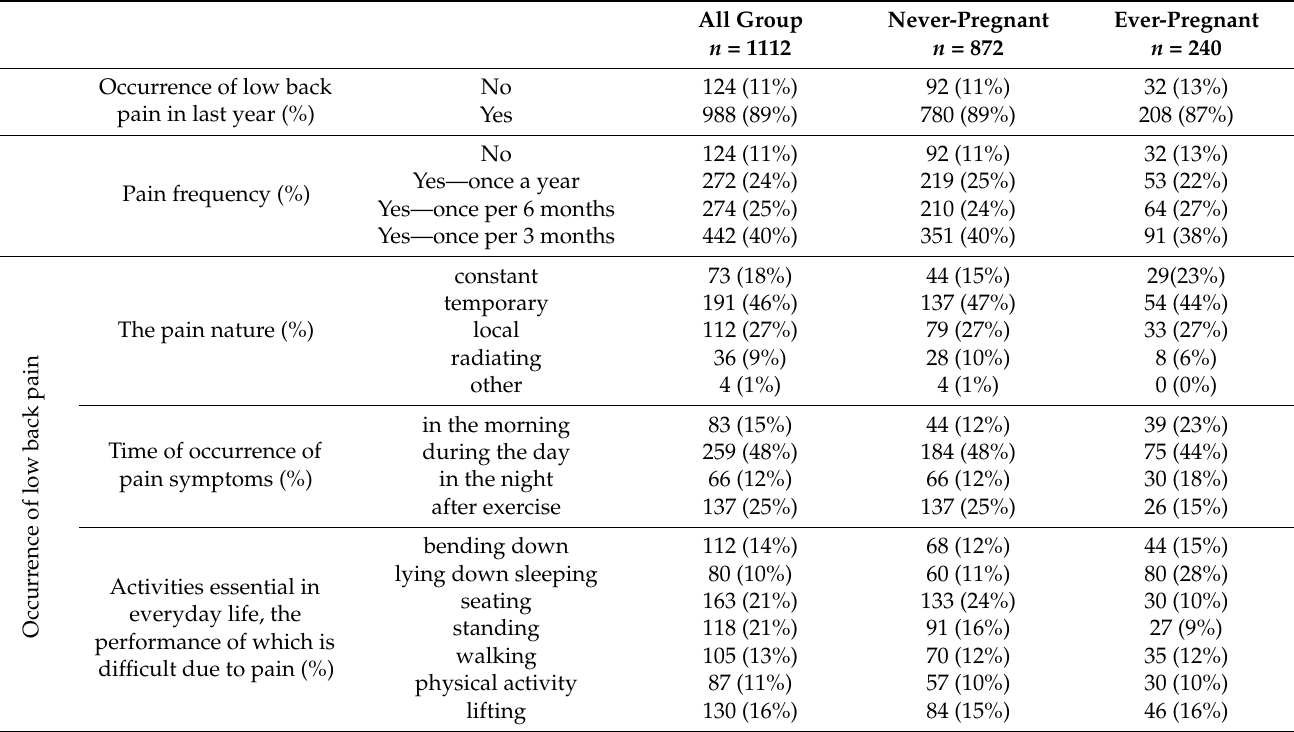
Table 2. Characteristics of the participants in terms of the occurrence of pain.